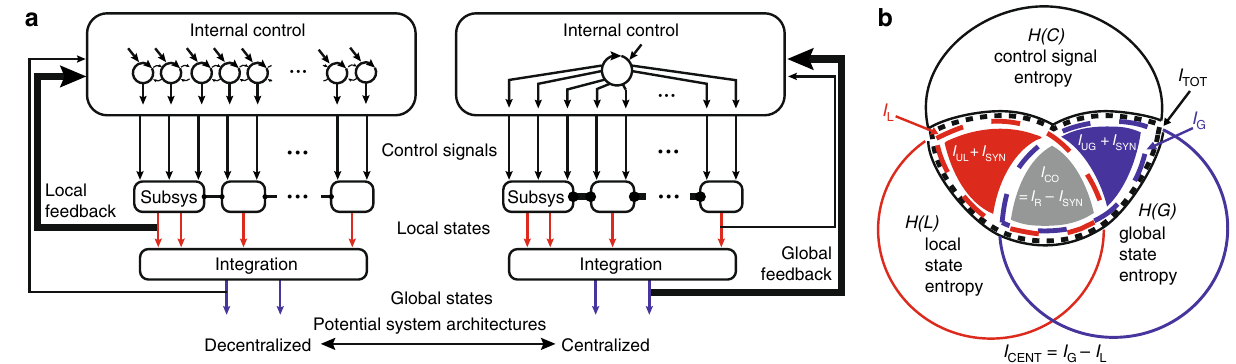
Fig. 1 Measuring Centralization of Locomotor Systems. a Locomoting systems can use numerous possible control signals which cascade information through successive levels of integration to effect a relatively small number of global task related outcomes. Coupling between control can range from weak and local (decentralized) to strong and global (centralized). Arrows indicated direction of information fl ow. Lines connecting the subsystems represent mechanical coupling, with thickness signifying coupling strength. Centralization could also be affected by the degree of coupling in the internal architecture of control, as well as the strength of global feedback versus local feedback. b Our centralization measure uses empirical observations of control signals, local states, and global states to infer the coupling of control. We estimate the mutual information between the control signal and both the global and local states. We measure centralization as I G minus I L , which removes any I R between the three variables. We expect decentralized systems to contain more I L and centralized systems to contain more I G . I UG , I UL , I SYN , and I R are the unmeasured constituent parts of the total information I TOT shared between the control signal and both local and global